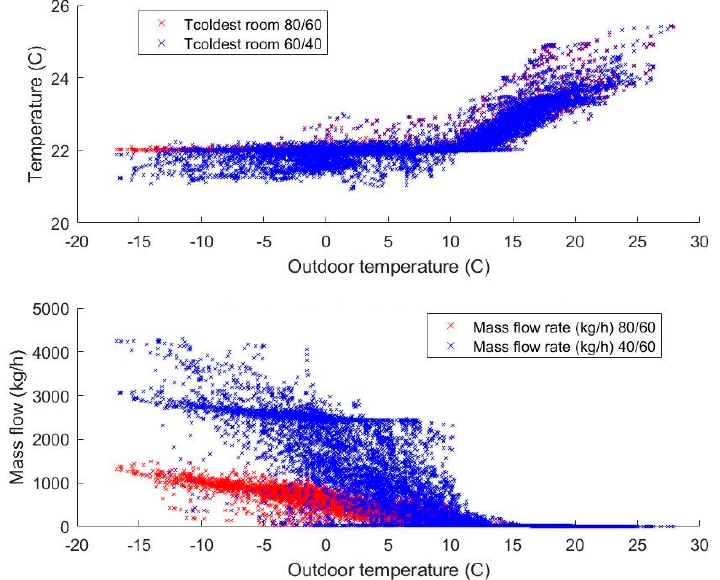
Figure 8. Temperature in the coldest room ( top ) and mass flow rates ( bottom ) relative to the outdoor temperature for AB_03 standard renovated.